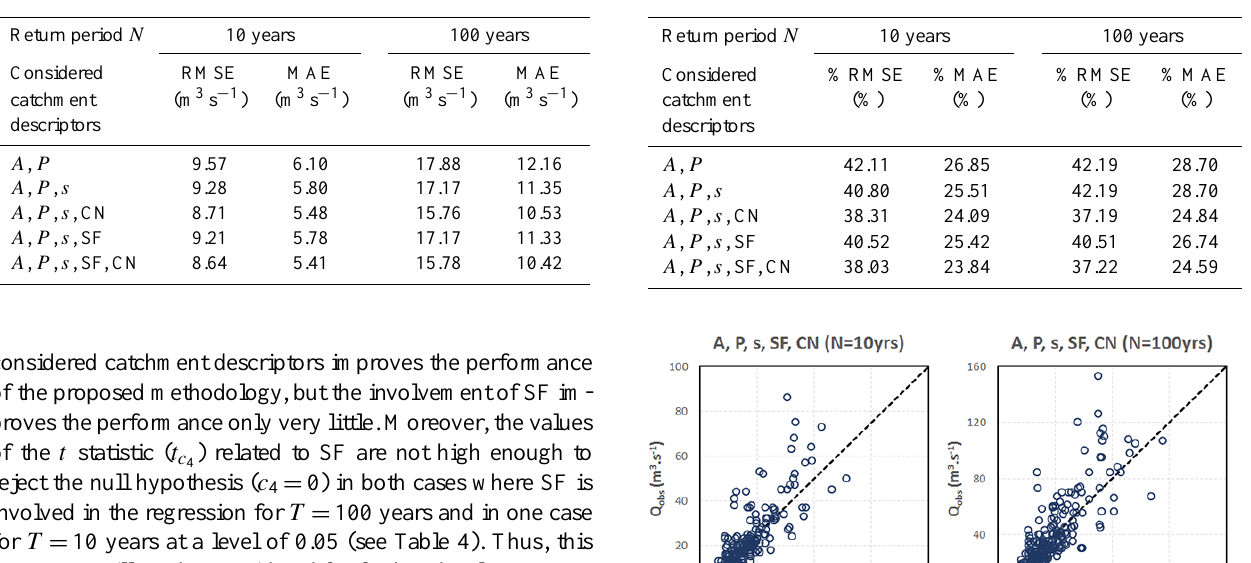
Table 1. Values of RMSE and MAE for all considered combinations of involved catchment descriptors.